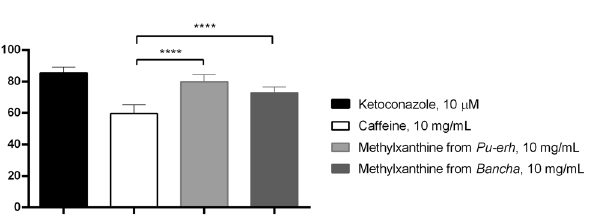
Figure 4. Chromatograms of caffeine, theophylline and theobromine (ST, standard substances) at concentrations of 10 µ g/mL and that of the methylxanthines extracted from Pu-erh and Bancha tea leaves.